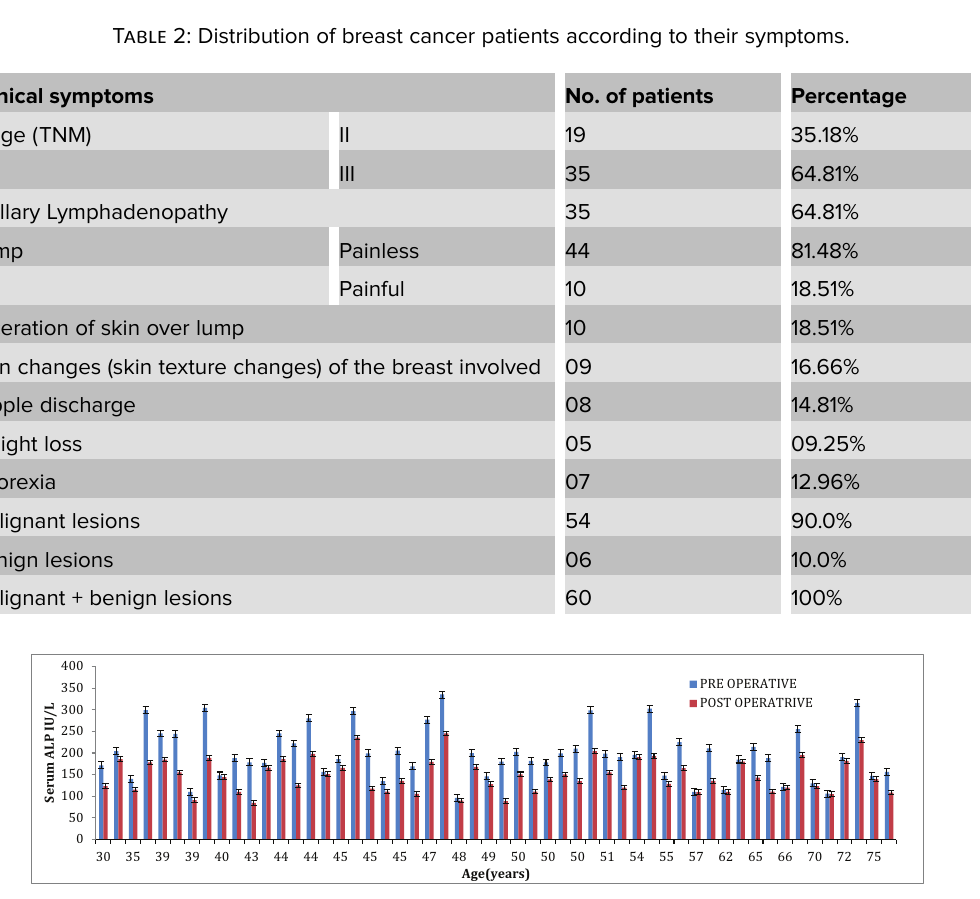
Figure 1 : Pre- and postoperative serum alkaline phosphatase levels in different age groups of breast